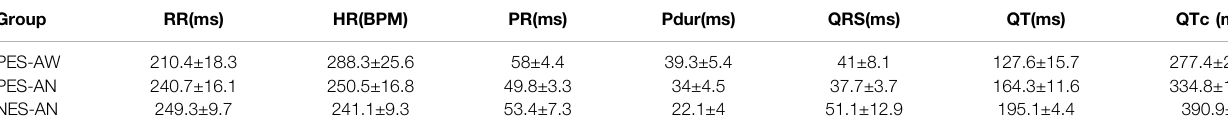
TABLE 1 | Effect of three different recording methods on ECG parameters in young female guinea pigs. Group